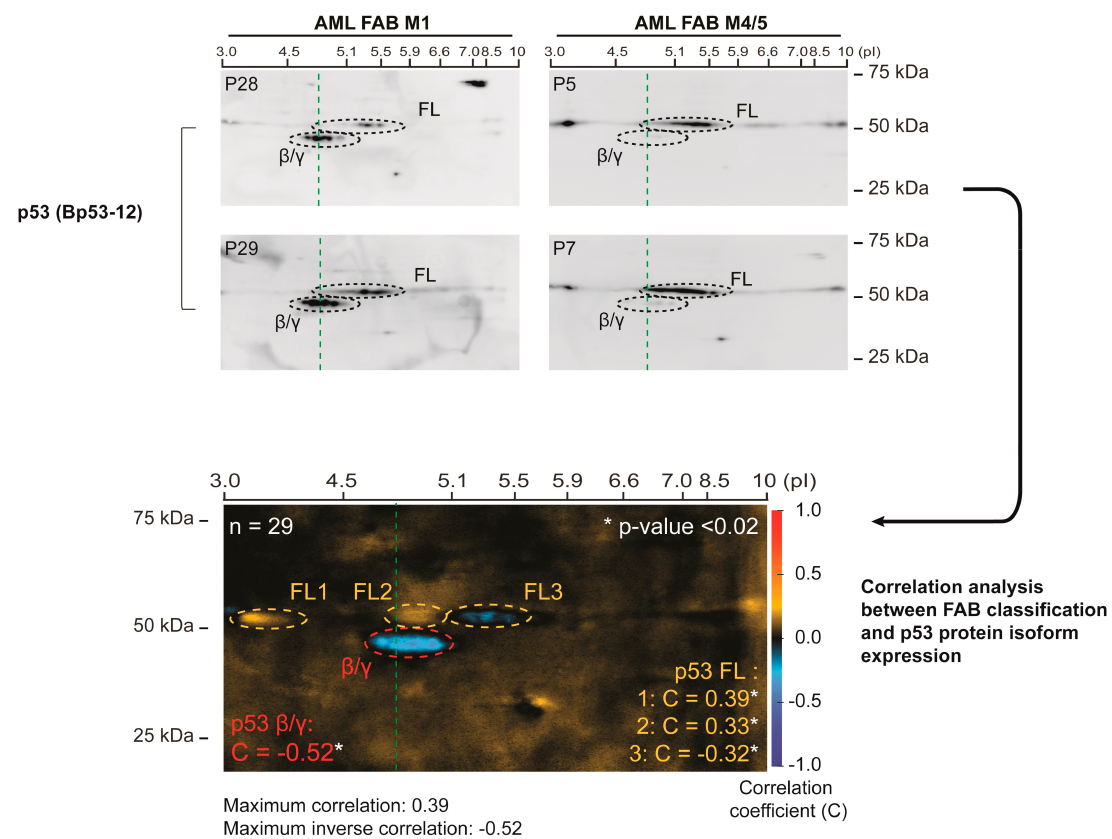
Figure 2. Correlation analysis between p53 protein isoform expression and morphological differentiation stage (French– American–British classification) of AML blasts. 29 primary AML samples with defined FAB classification were analyzed by 2D gel electrophoresis and Western blotting using an antibody against p53 (Bp53-12) for the detection of p53 full length (FL), p53 β and p53 γ protein isoforms. Examples of p53 protein isoform expression in p53 2D gel images from patient samples of low and high FAB class (M1 versus M4/5) are shown. A correlation analysis between p53 protein isoform expression and FAB classification (patient samples were assigned values from 0-6 based on FAB class) of the AML blasts was performed. Regions with significant correlation values are indicated (the red color indicates positive correlation, the blue color indicates negative correlation): β / γ region: correlation coefficient = − 0.52, t -value = 4.51, p -value < 0.005), FL1: correlation coefficient = 0.39, t -value = 3.14, p -value < 0.005, FL2: correlation coefficient = 0.33, t -value = 2.59, p -value < 0.02), FL3: correlation coefficient = − 0.32, t -value = 2.50, p -value < 0.02.